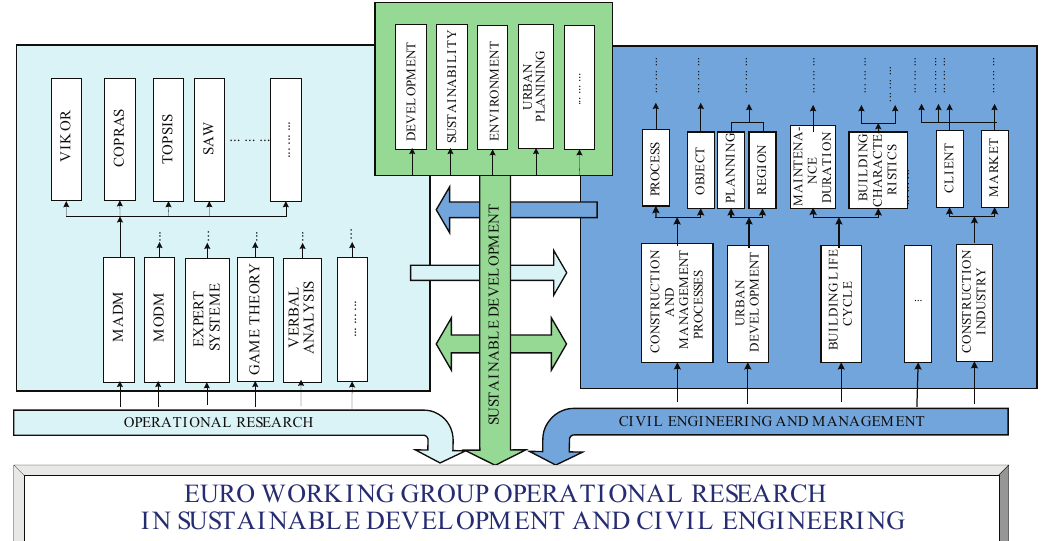
Fig. 2. The general topics of the new working group OR in Sustainable Development and